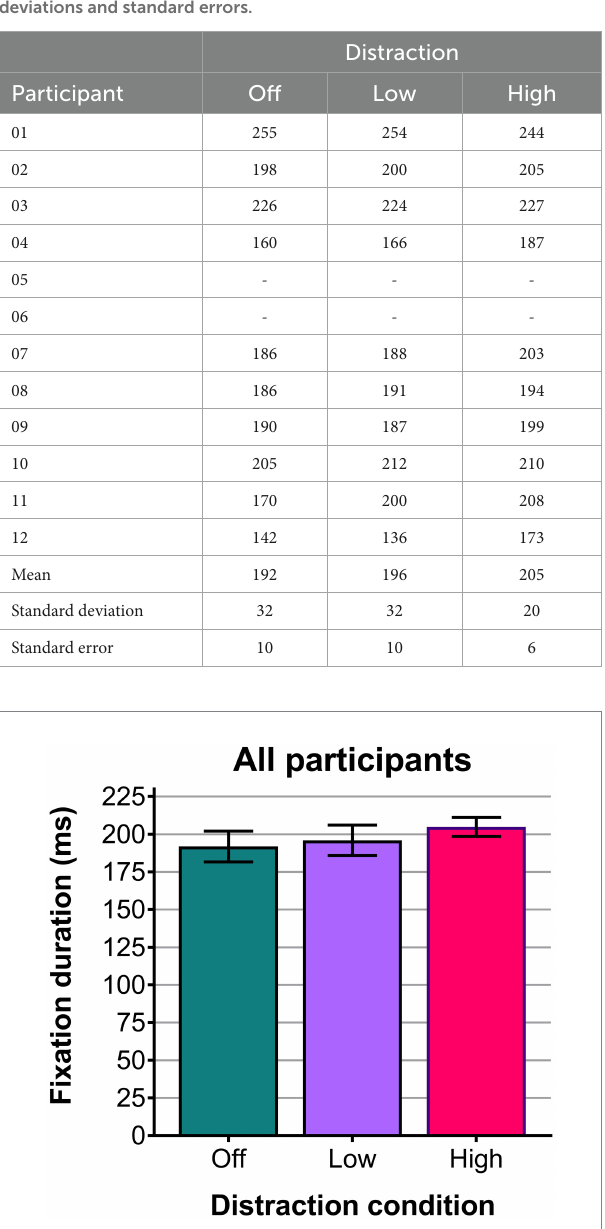
FIGURE 7 Plot of the mean fixation duration (milliseconds) across all 10 participants for the three distraction conditions. Error bars show the standard